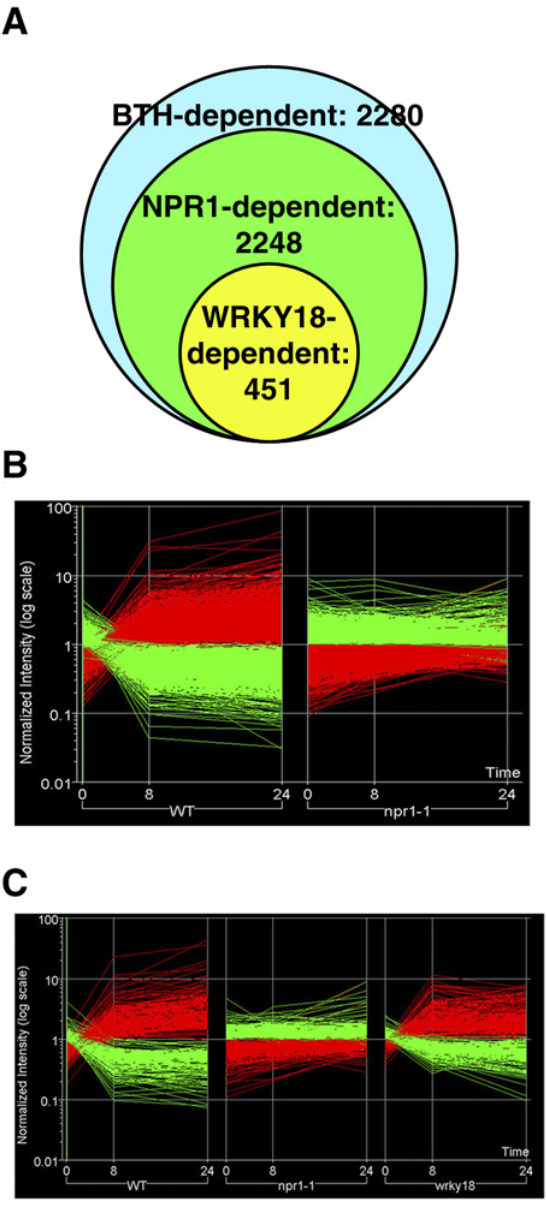
Figure 4. Genes Affected by BTH, npr1, and wrky18 0, 8, and 24 h after Induction Using ANOVA, the expression of 6,525 genes was found to be altered in WT following BTH treatment ( p , 0.05) (after multiple testing correction using the method proposed by Benjamini and Hochberg to assess false discovery rate [22]). After applying a 2-fold change cutoff to these genes, the list was reduced to 2,280 genes, among which 1,147 were induced and 1,133 were repressed. From this list, a two-way ANOVA was applied between WT and npr1 data sets and between WT and wrky18 data sets to identify NPR1-dependent and WRKY18- dependent genes, respectively. (A) The Venn diagram shows that almost all BTH-responsive genes were NPR1-dependent (2,248/2,280; 99%) whereas the expression of 451 BTH- responsive genes ( ; 19.8%) was altered in the wrky18 mutant. (B) The expression levels of 2,280 BTH-dependent genes normalized by GeneSpring were plotted on log scale on the y -axis and in time order on the x -axis. Genes induced and repressed in WT are colored red and green, respectively. The profile of these genes in the npr1 mutant is also depicted. (C) The expression levels of 451 WRKY-dependent genes in WT and in wrky18 mutant were normalized by GeneSpring and plotted on log